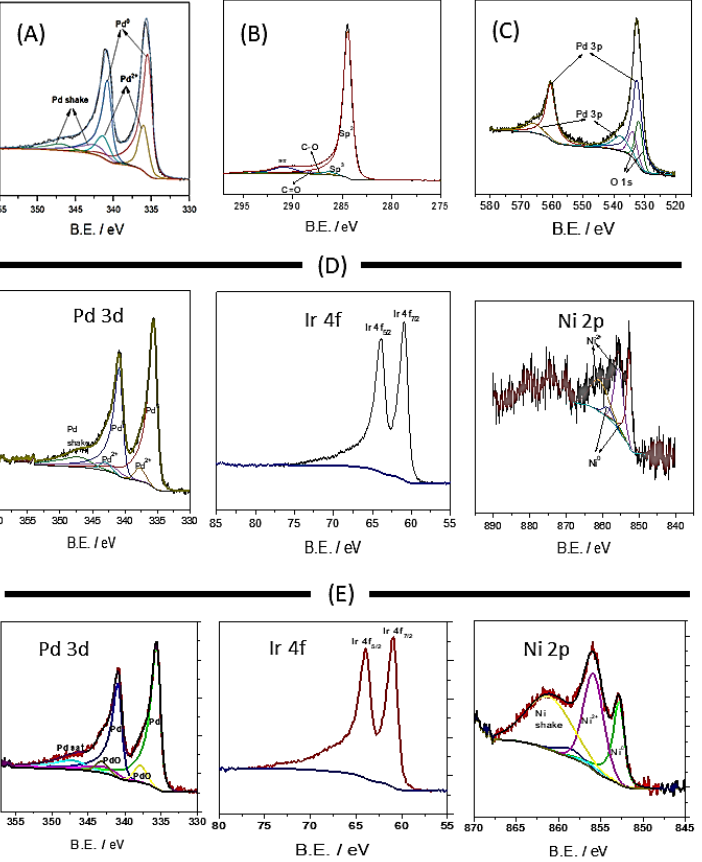
Figure 6. XPS peaks of Pd 3d ( A ), C 1s ( B ), Pd 3p + O 1s ( C ) in Pd/C, peaks of Pd 3d, Ni 2p, Ir 4f of Pd 4 Ir 2 Ni 1 /C ( D ) and PdIrNi/C ( E ).